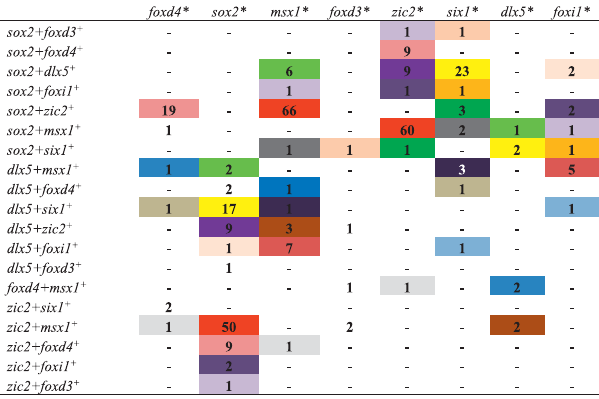
Cells labeled with the same color co-expressed the same combination of three domain- enriched transcription factors.